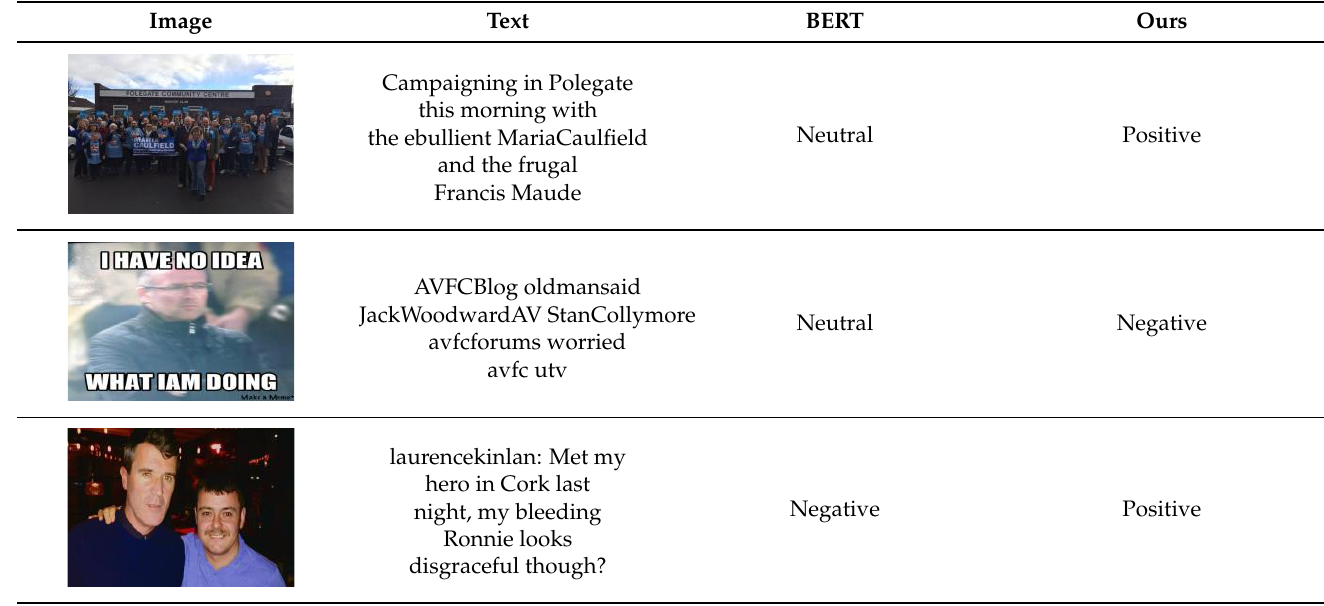
Table 5. Example of misclassified by BERT and correctly classified by Ours. Image